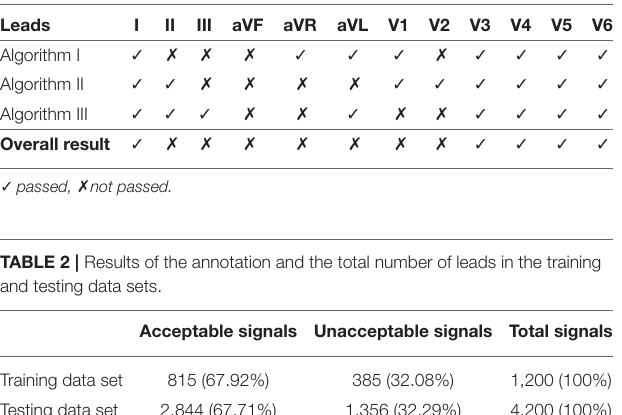
TABLE 1 | An example of the agreement rule for assessing the ECG quality of each lead.